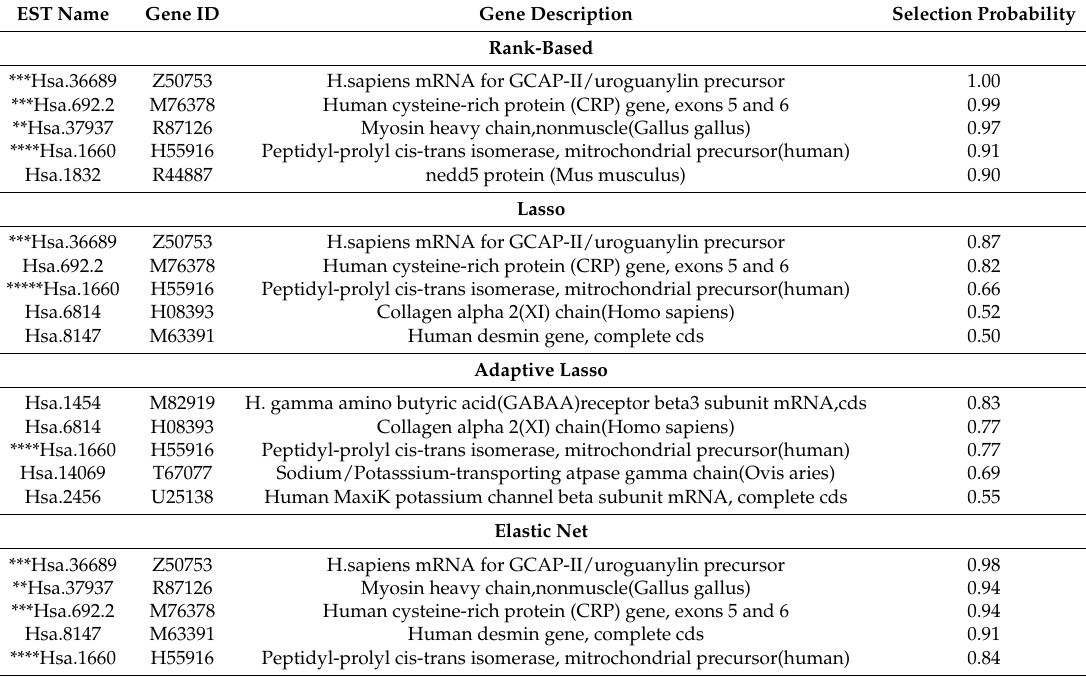
Table 9. List of top 5 ranked genes across rank-based, lasso, adaptive and elastic net. An extra asterix (*) sign is put next to a gene each time the gene is selected by one of four